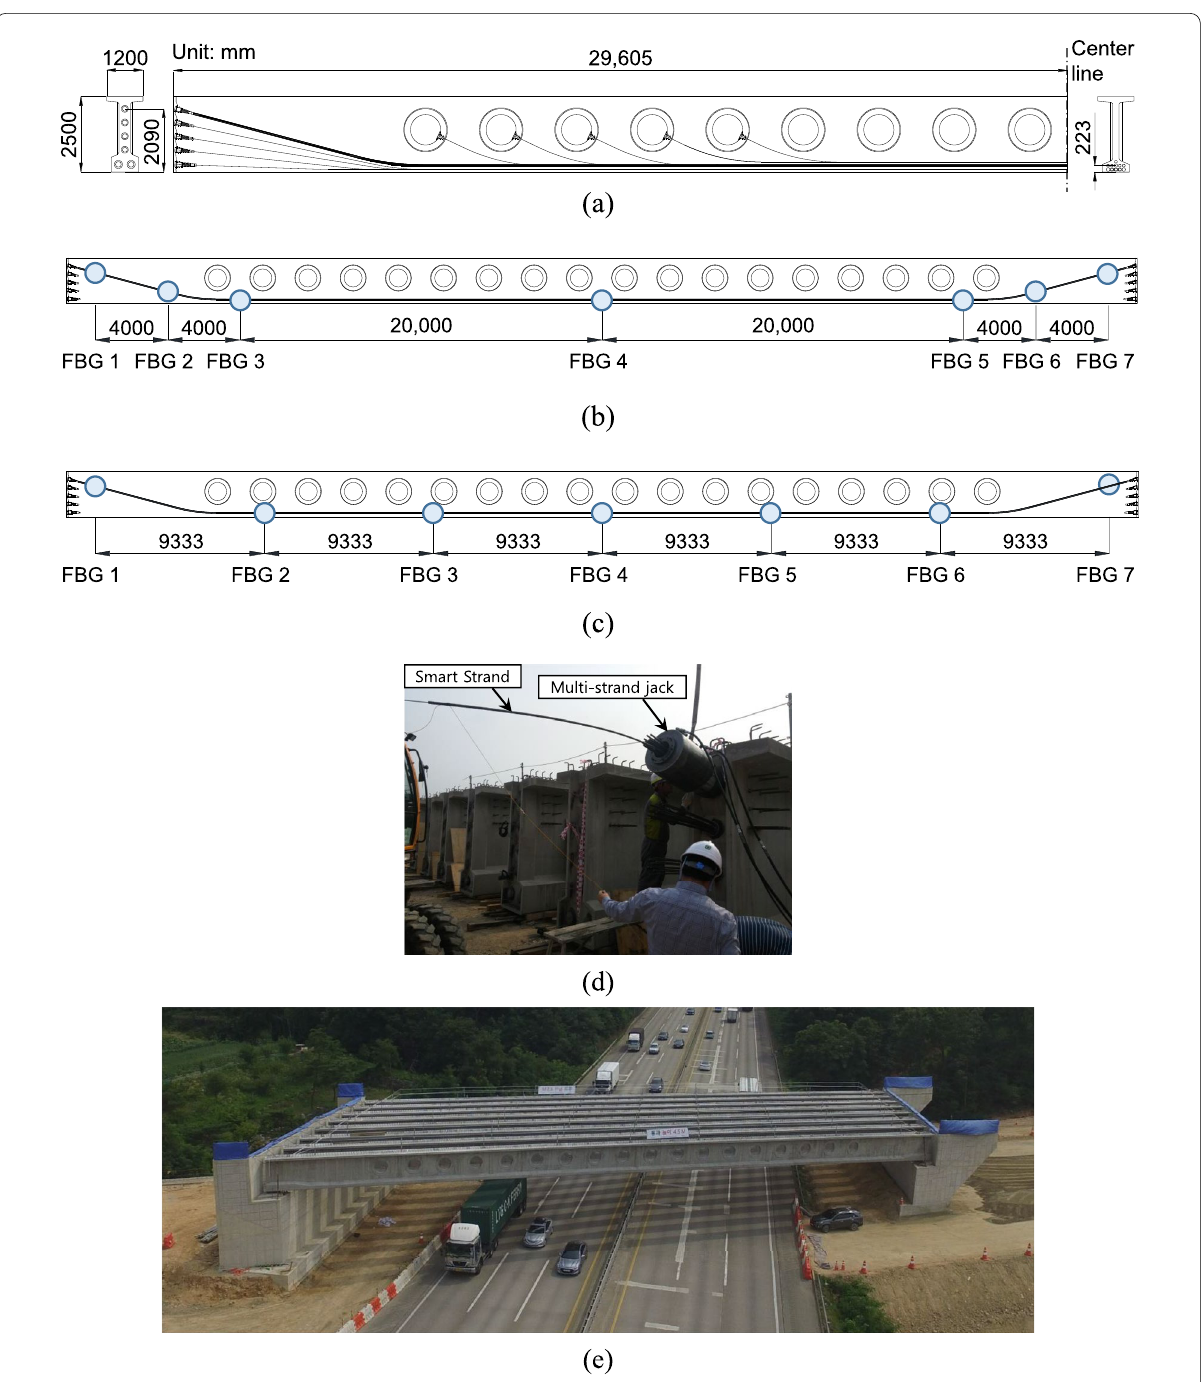
Fig. 7 PSC girder in bridge B: a Dimensions and arrangement of tendons; b location of the Smart Strand and FBGs (girder 1); c location of the Smart Strand and FBGs (girder 2); d tensioning of strands; e erected girders before placement of